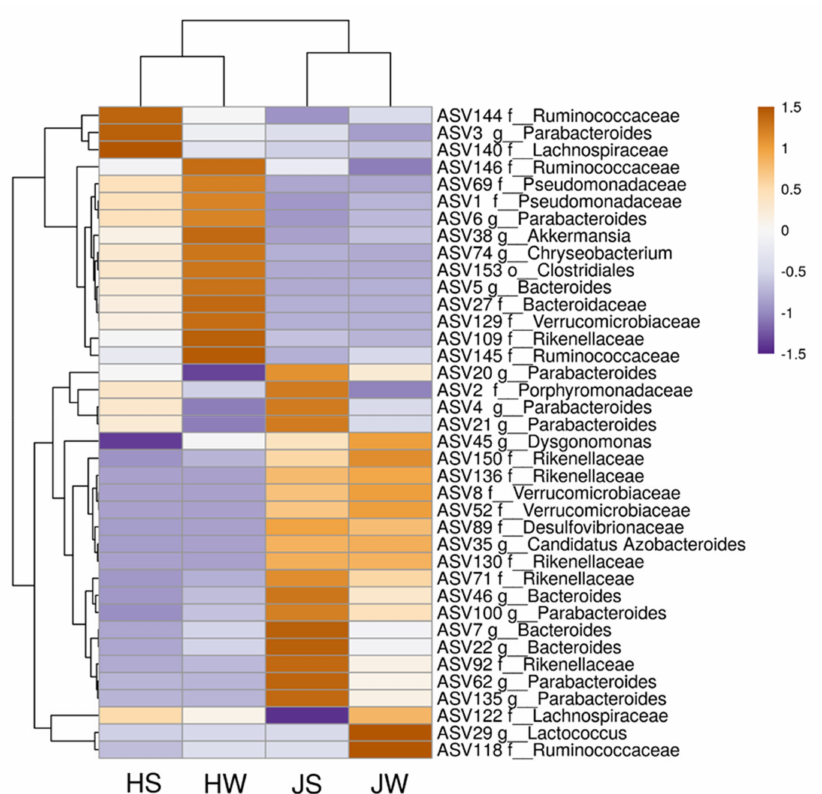
Figure 5. Heatmap of the most abundant unique bacterial ASVs on the Jamaican field and house cricket surface and whole-body samples. JS—Jamaican cricket surface, JW—Jamaican cricket whole- body, HS—house cricket surface, HW—house cricket